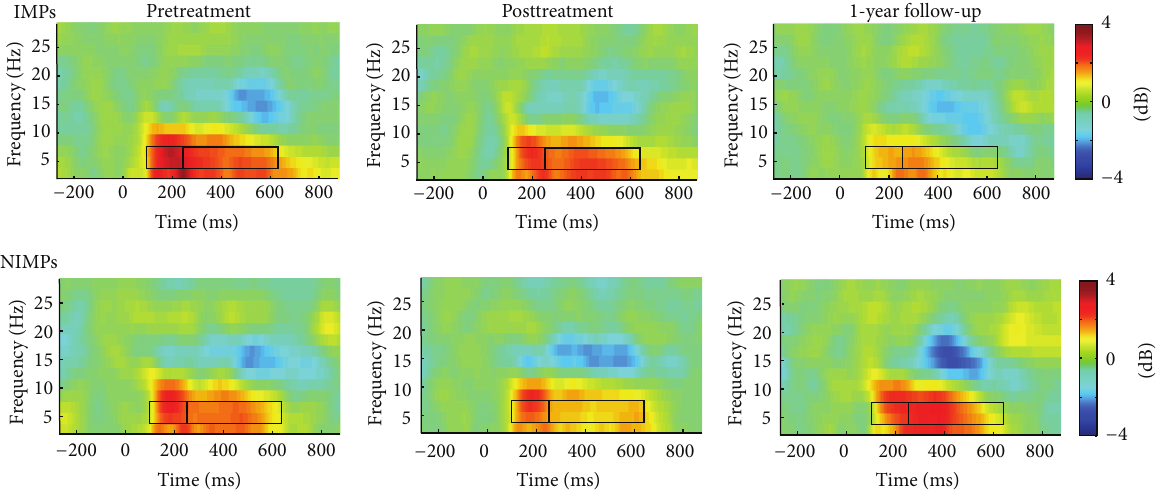
Figure 5: Time-frequency plots showing theta power (in dB) at each session (pretreatment, posttreatment, and follow-up) for improvers (IMPs) and nonimprovers (NIMPs) for our main analysis classifying improvement status by internalizing changes. Boxes delineate the early and later peak of the theta